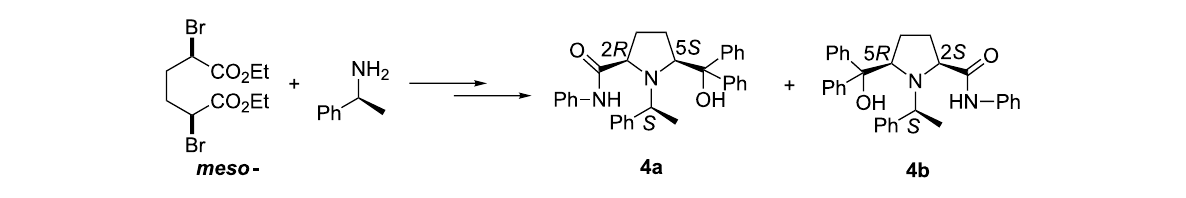
Figure 2: The synthesis of 4 ( previous work ).